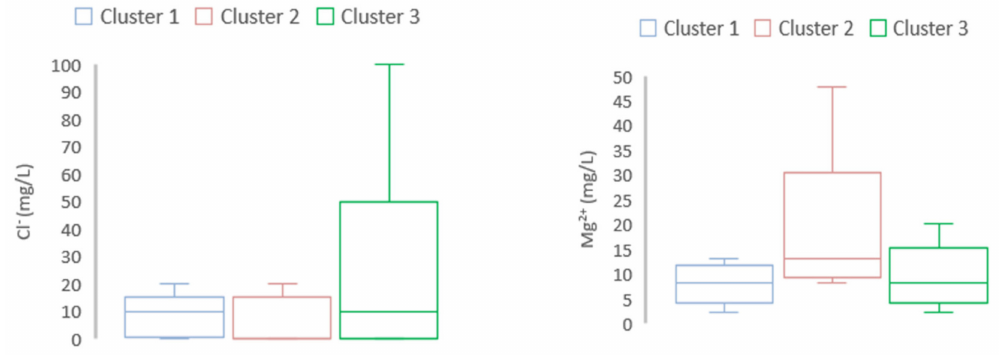
Figure 7. Water quality variables among the three clusters in the wet season. Mg 2 + was high in Cluster 2 while Cl − was high in Cluster